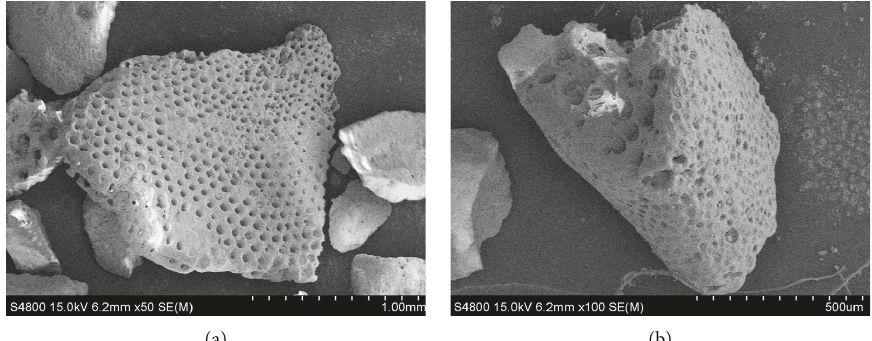
Figure 1: SEM micrographs of the calcareous sands. (a) 50x magnification. (b) 100x magnification.